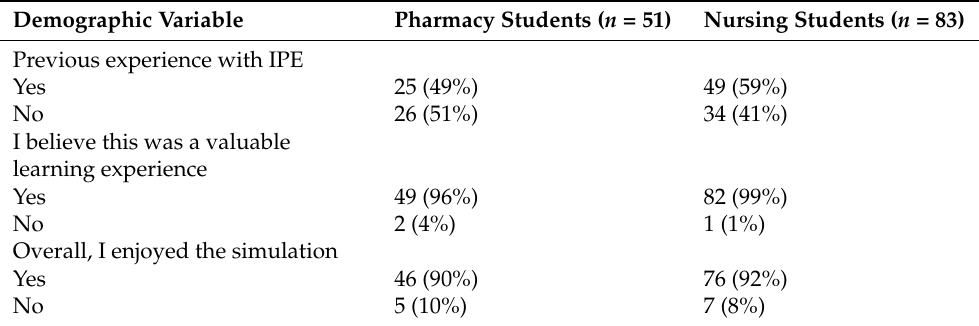
Table 2. Prior experience with IPE (POST) and post-simulation perceptions. Demographic